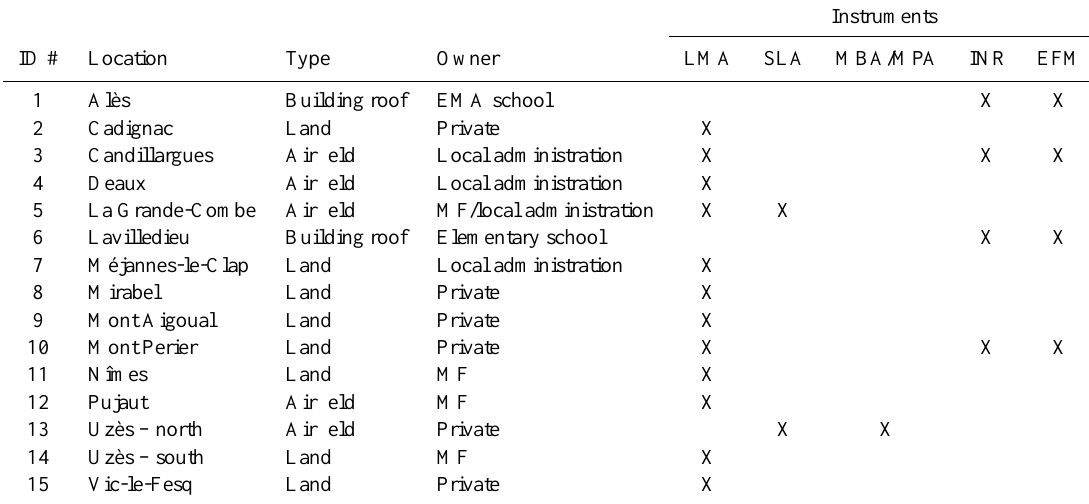
Table 1. Site ID numbers and locations of the PEACH SOP1 instruments. Sites of VFRS records are not indicated here. MF stands for Météo-France; EMA for Ecole des Mines